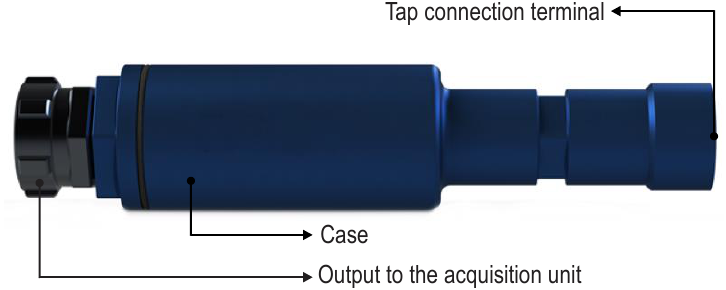
Figure 4. Coupling Figure 4. Coupling device. Figure 4. Coupling device.